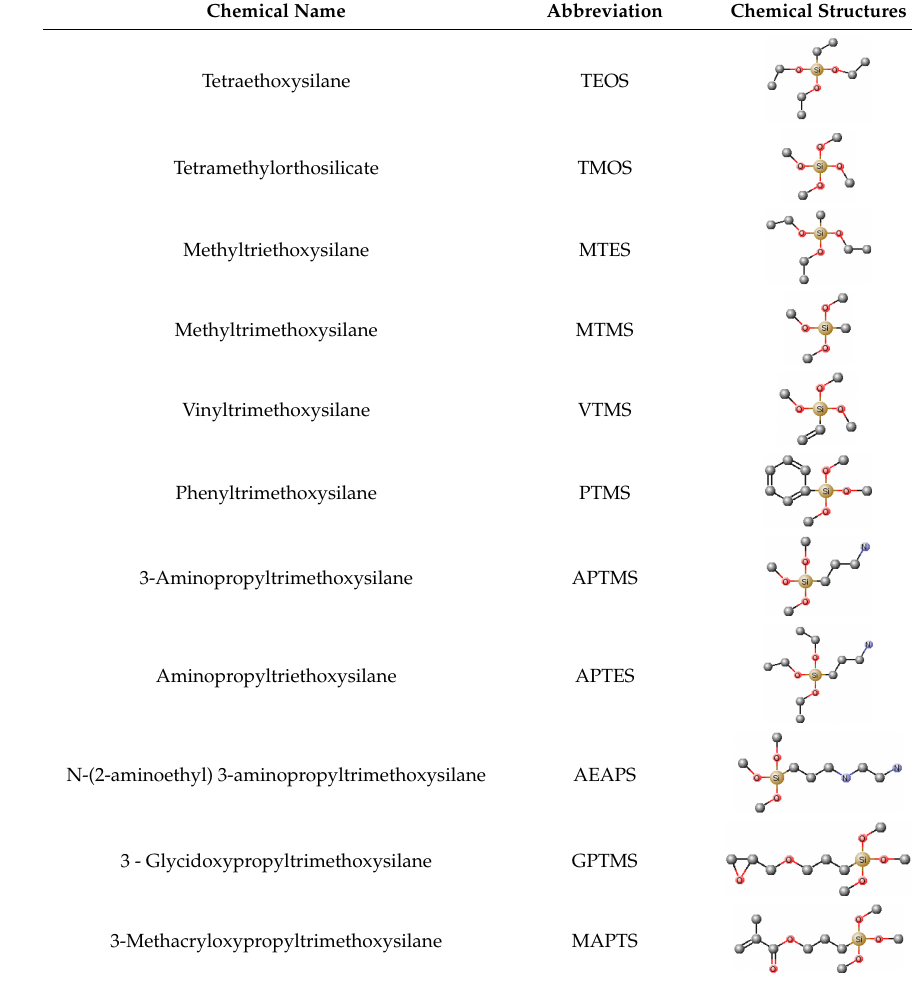
Table 1. Abbreviation, chemical name and structure of each of the alkoxysilanes most used as precursors for synthesis of OIH